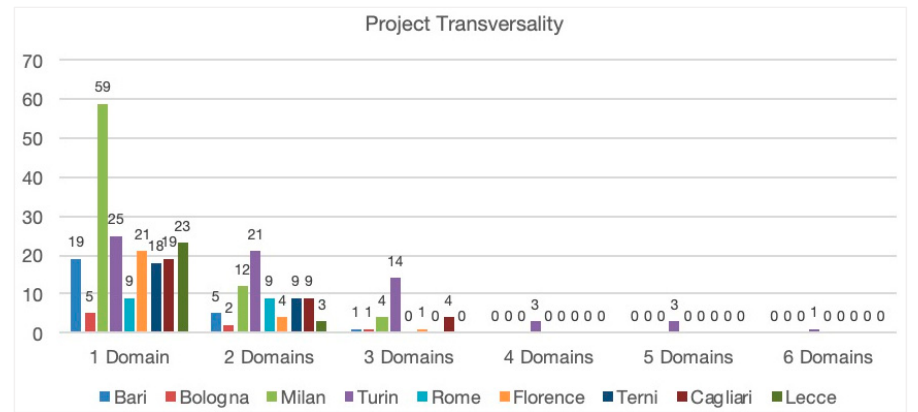
Figure 7. Projects’ transversality for single Smart city.